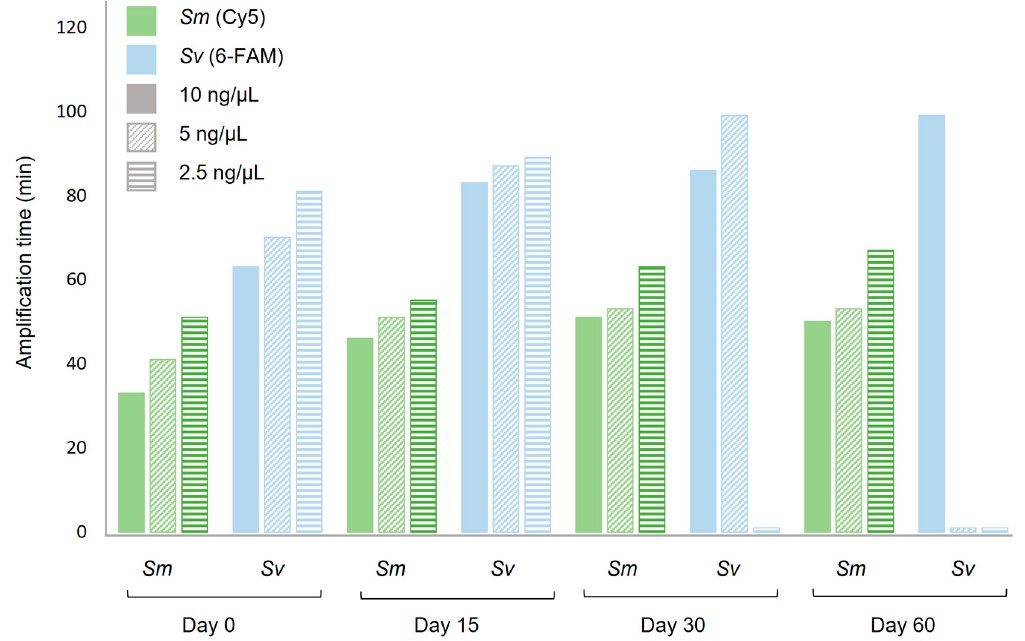
Figure 5. Amplification time of duplex Dry-DARQ-LAMP assays as a function of storage time at ambient temperature. Amplification times of different concentrations of gDNA (10 ng/ µ L, 5 ng/ µ L and 2.5 ng/ µ L) from both Schistosoma mansoni ( Sm ) and Strongyloides venezuelensis ( Sv ) in duplex DARQ-LAMP assays performed with dry mixtures containing sets of primers and fluorescence labelled-probes tested at 0, 15, 30 and 60-days post-desiccation are represented. Al reactions were performed in a Genie III portable instrument.